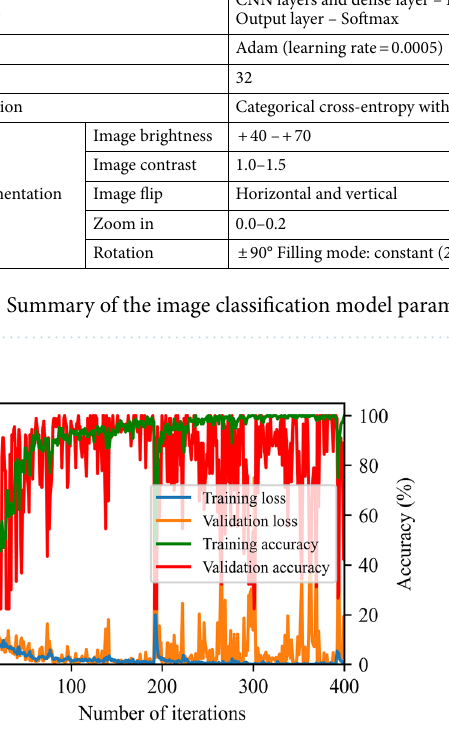
Figure 6. The training process of the image classification model: training and validation accuracy, and training and validation